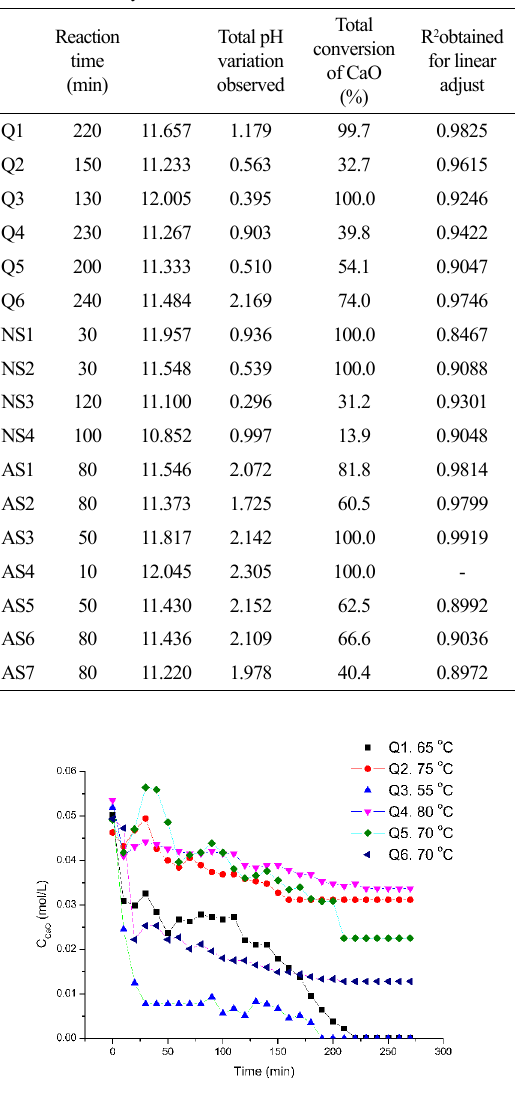
Figure 8. Kinetic experiments conducted with crystalline quartz as the silica source. The lines are guides for the